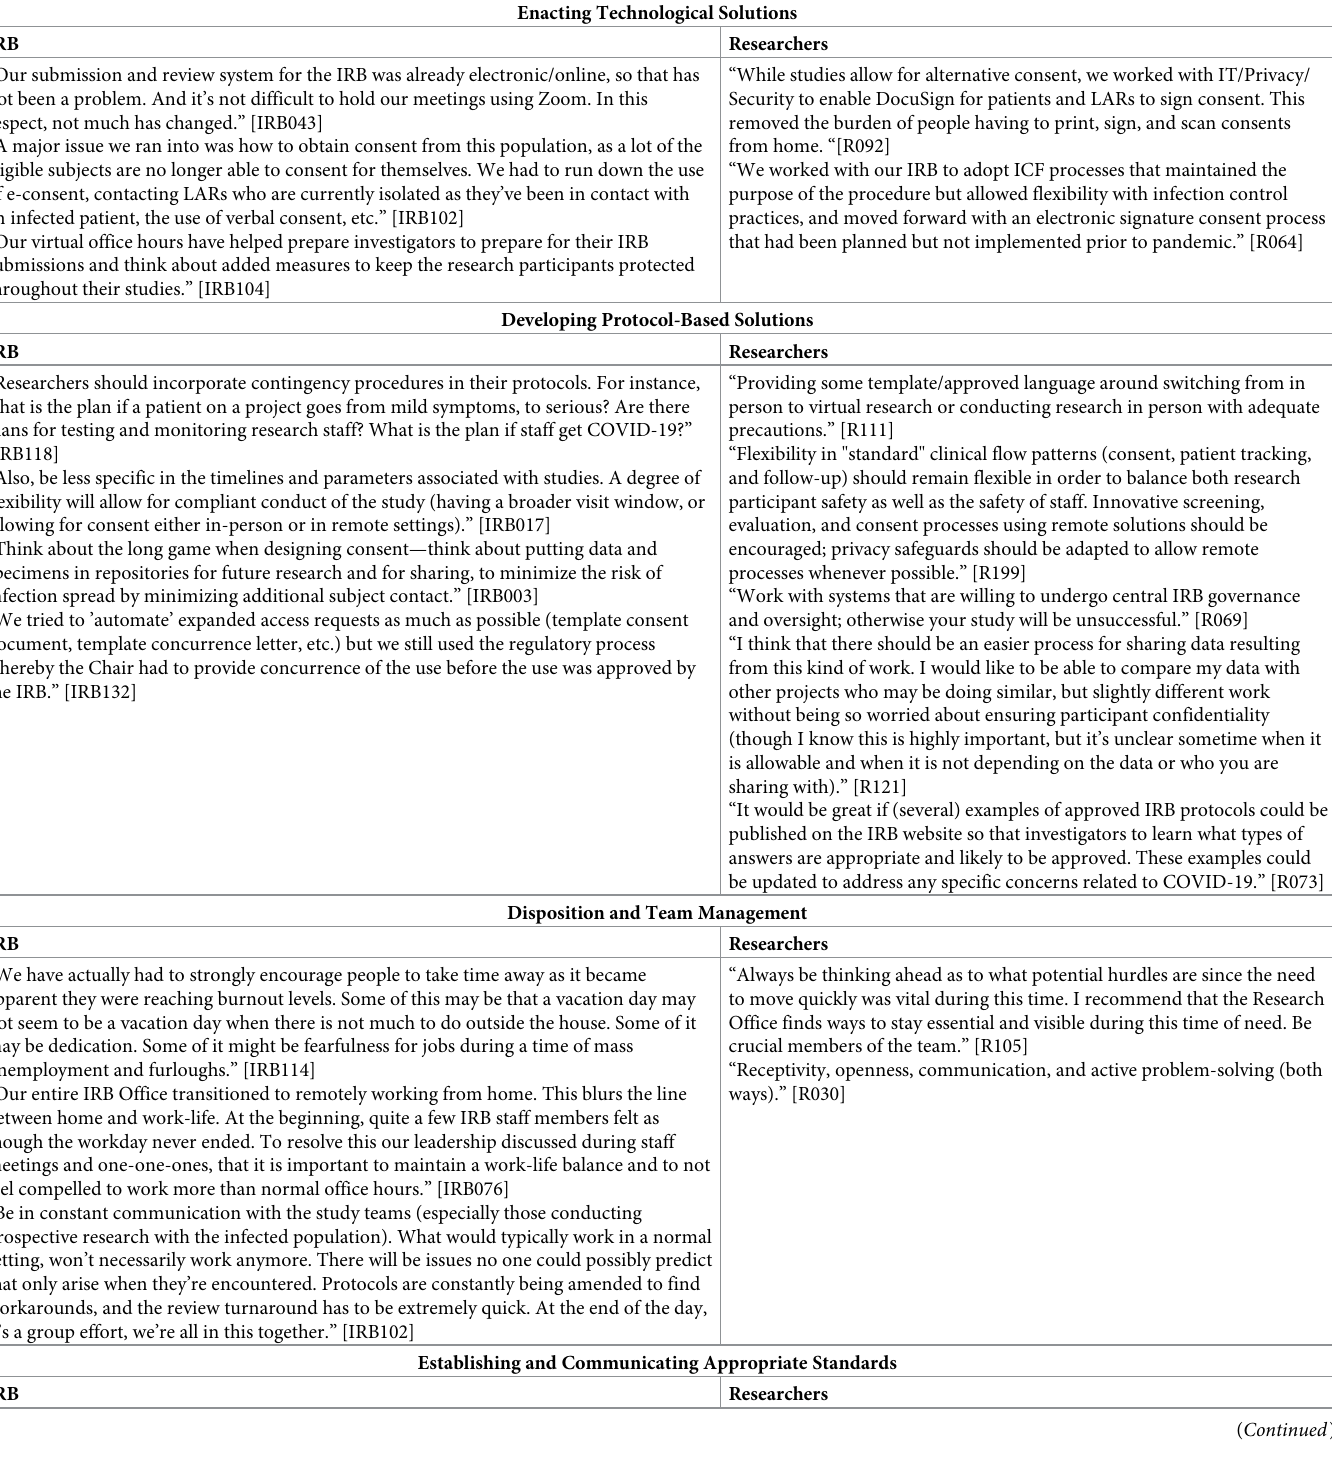
Table 5. Proposed adaptations and